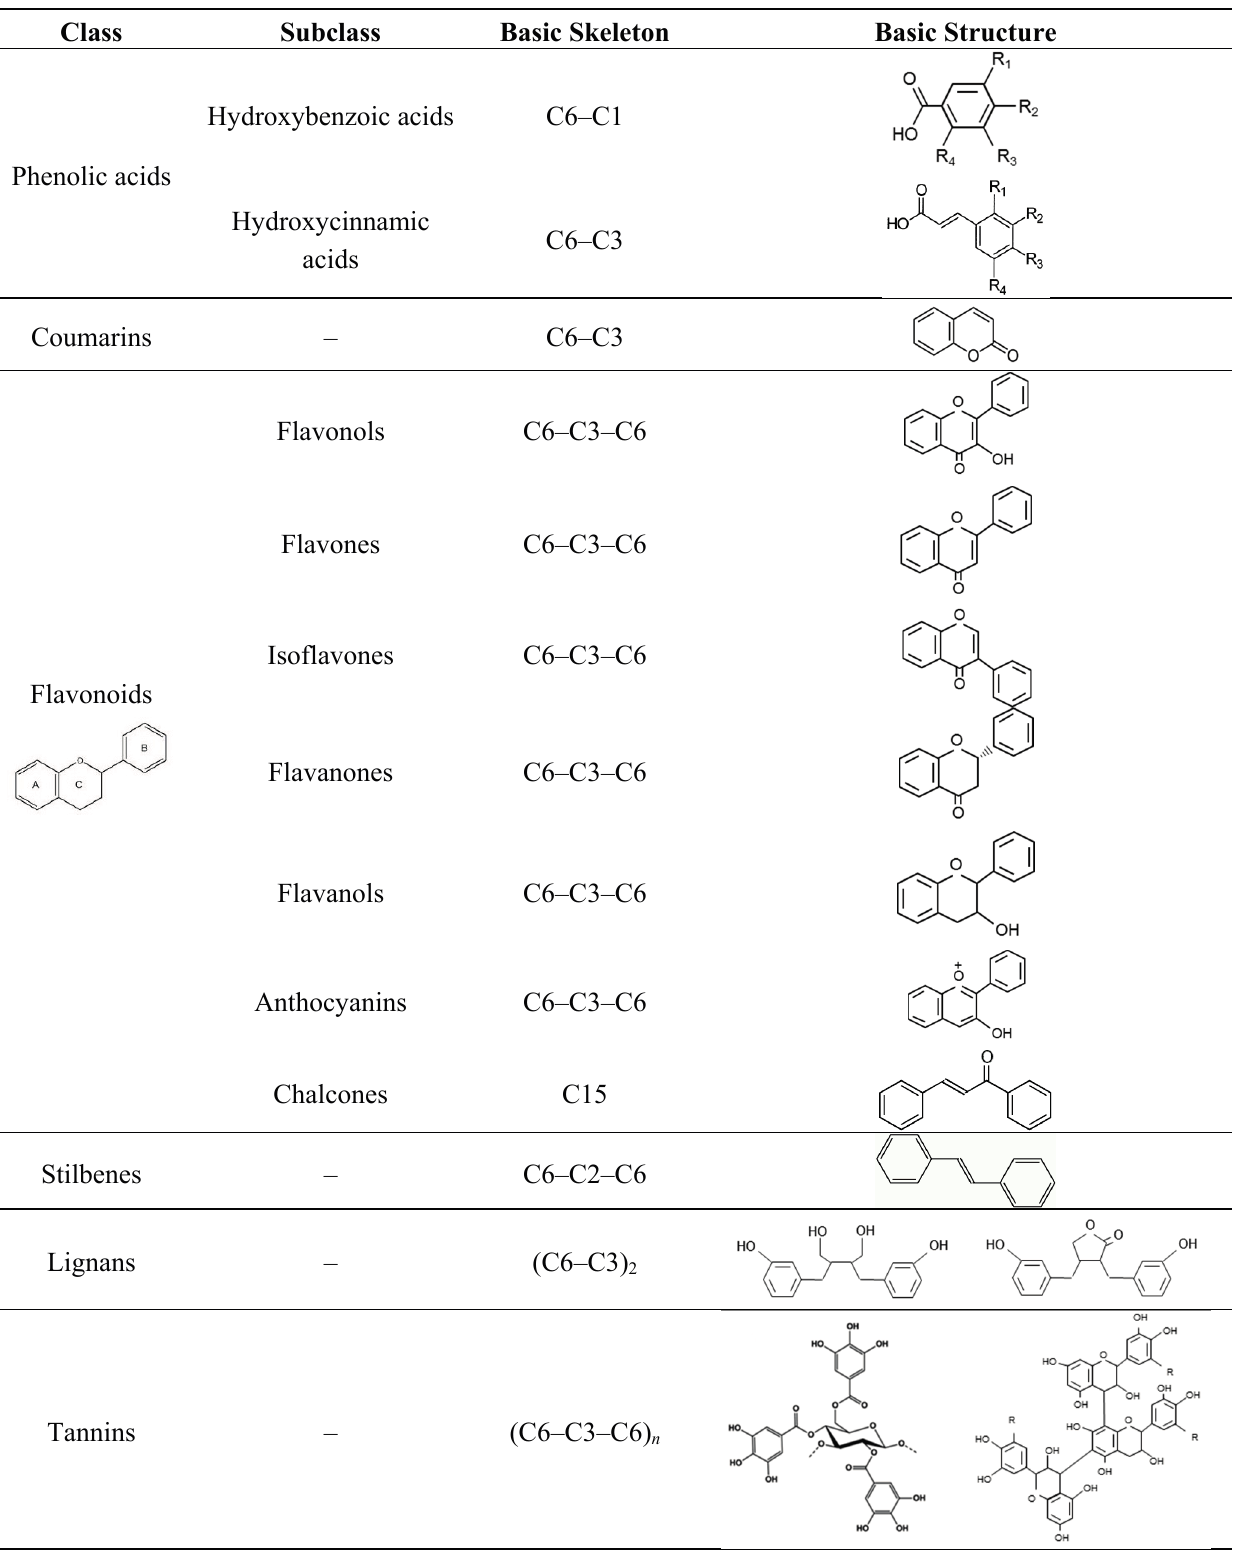
Table 1. Chemical structures of the main phenolic